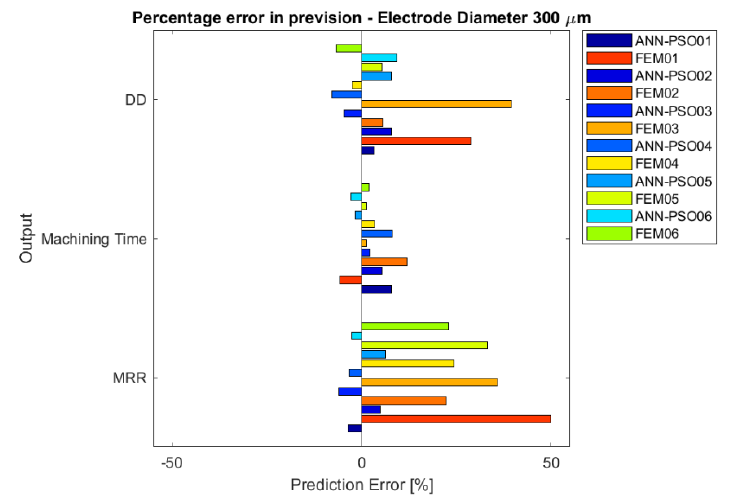
Figure 5. Bar chart of percentage error between simulation models and experimental tests, for drilling process performed by means of an electrode with a diameter equal to 300 µm.